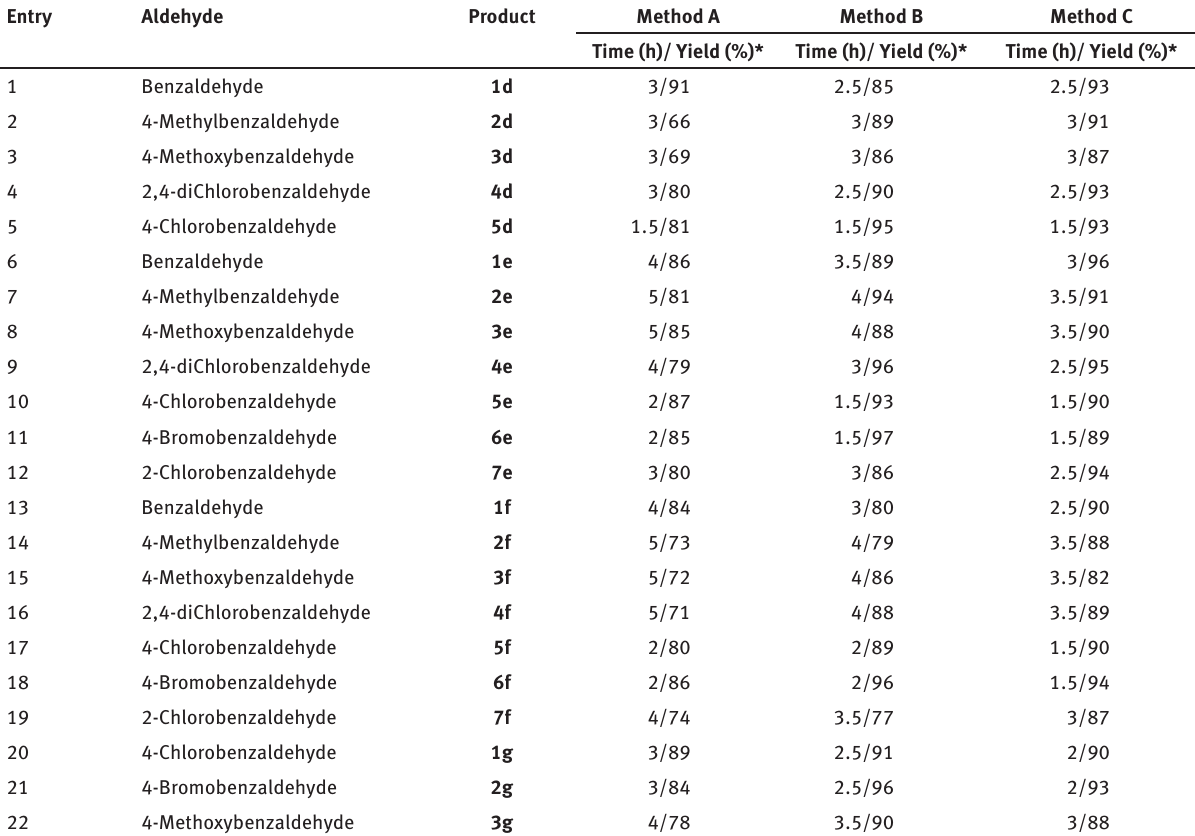
SiO (with 2% w/w of SnFe 2 3